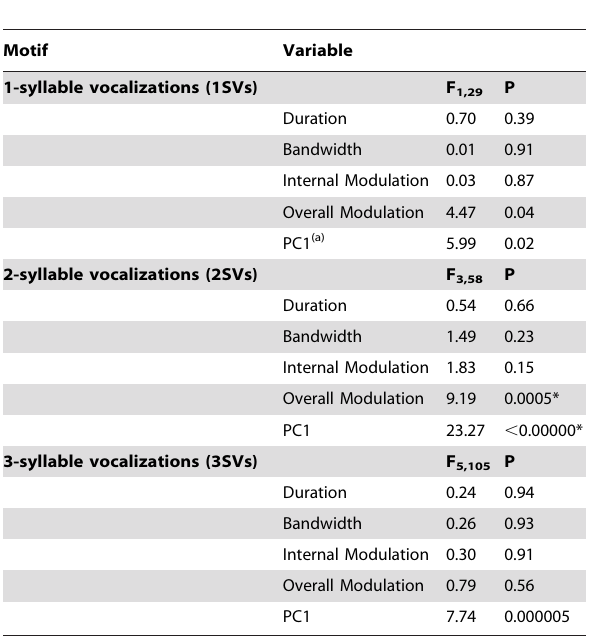
Table 4. Homogeneity of variance (b) between laboratory- and wild-recorded 1SVs, 2SVs, and 3SVs.